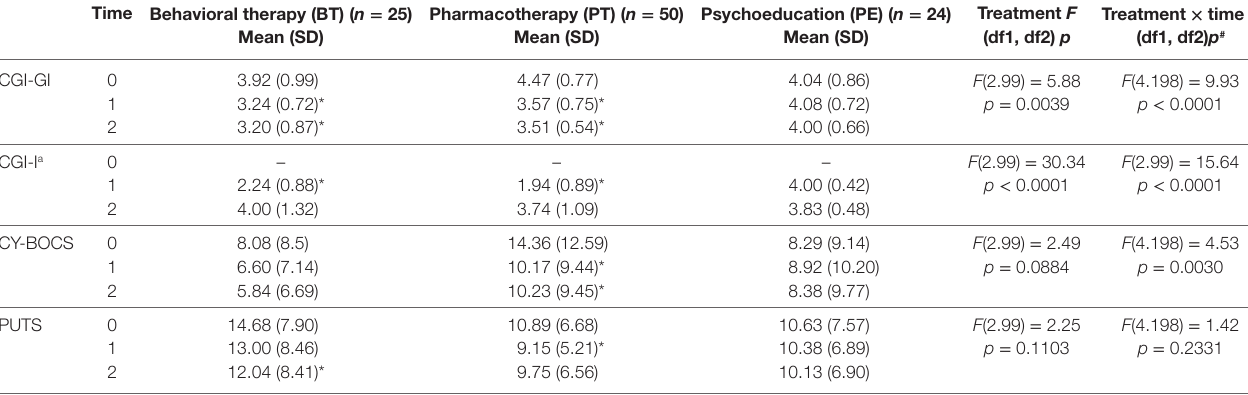
TaBle 3 | CGI-GI, CGI-I, Children’s Yale-Brown Obsessive-Compulsive Scale for Children (CY-BOCS), Premonitory Urge for Tic Scale (PUTS) outcome (values are expressed as absolute scores). Time Behavioral therapy (BT) ( n = 25) Mean (sD)